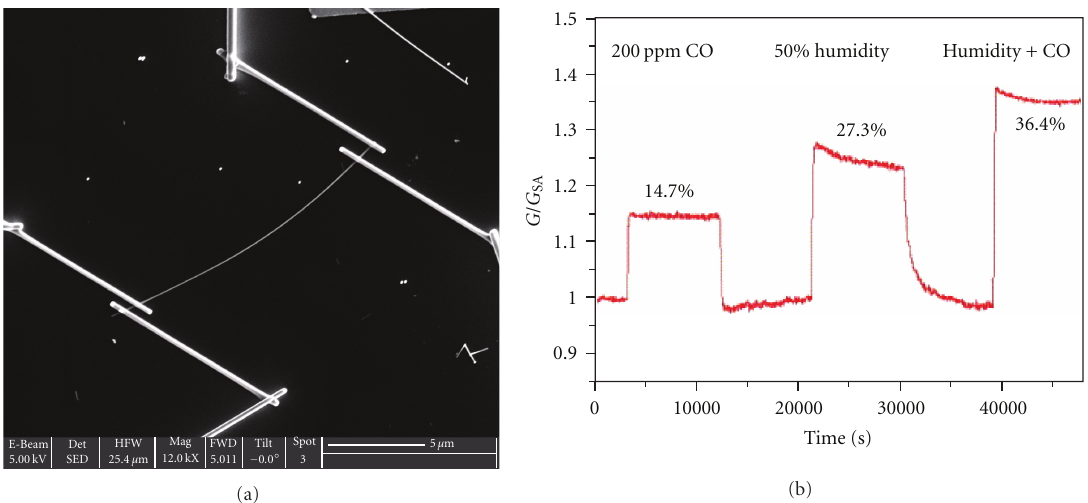
Figure 6: (a) A single SnO 2 nanowires contacted in a 4-probes configuration. (b) Comparison between the simultaneous detection of 200ppm of CO and 50% of RH.